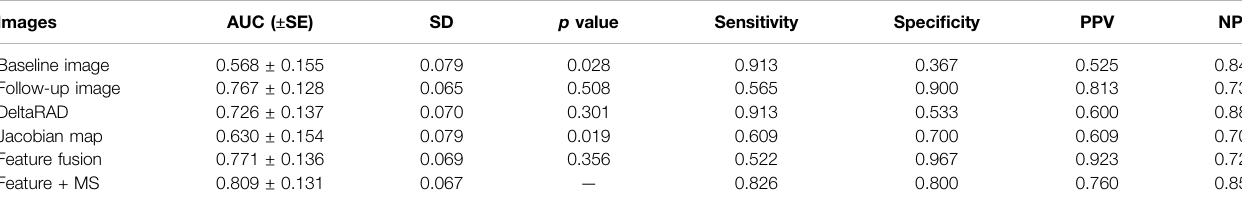
TABLE 3 | Performance of predictive model based on images at longitudinal times. Images